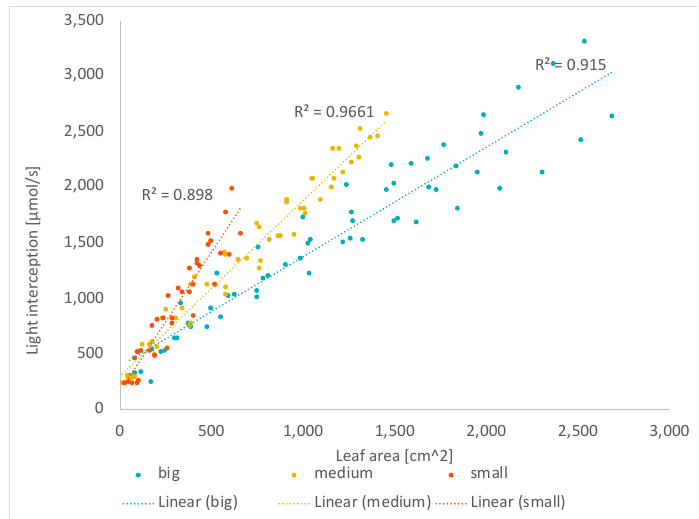
Figure 7. Scatterplot of light interception ( µ mol s − 1 ) against leaf area (cm 2 ) of three groups with different leaf sizes (big, medium, small) within scenario 1 s1 (27.8% of diffuse light, 426.41 µ mol/m 2 s of incident PAR). The light interception and leaf area were cumulated from the top of plant to the lowest by layers. Each scenario of light condition was fitted linearly with R-squared (R 2